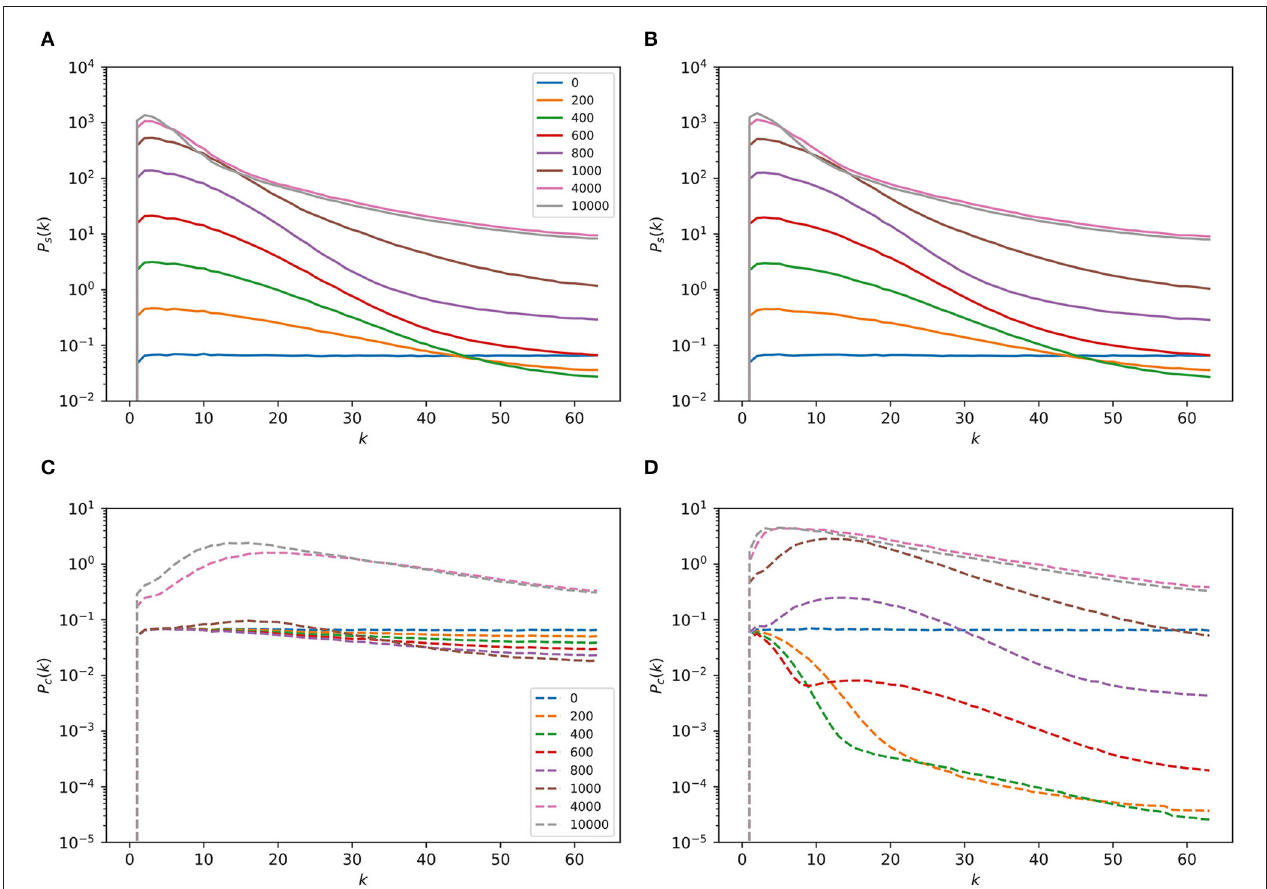
FIGURE 4 | Time evolution of the angular average of the power spectra of the nematization P s ( k ) and the concentration P c ( k ), as functions of the wave number k , from the scalar Equations (9) for conditions of low and high NP mobility R : (A) P s ( k , t ) for R curve corresponds to the time indicated in the inset legends. While the nematization power spectrum increases quickly and steadily, the concentration power spectrum P c ( k ) for low NP mobility goes through a quiescent stage before undergoing sudden increase, and even initially decreases at high wave numbers for high NP mobility. Parameters g 0.005, r 1, c 0 0.01 were fixed through the = = − =